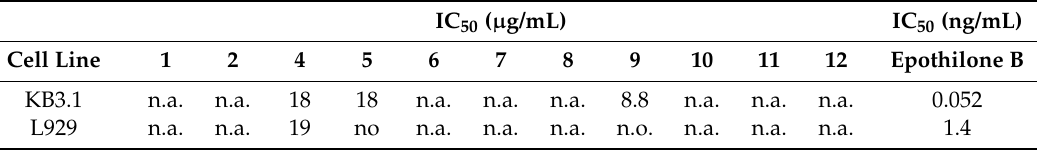
Table 4. Cytotoxic effect (IC 50 ) of Compounds 1 , 2 , and 4 – 12 against two cancer cell lines.